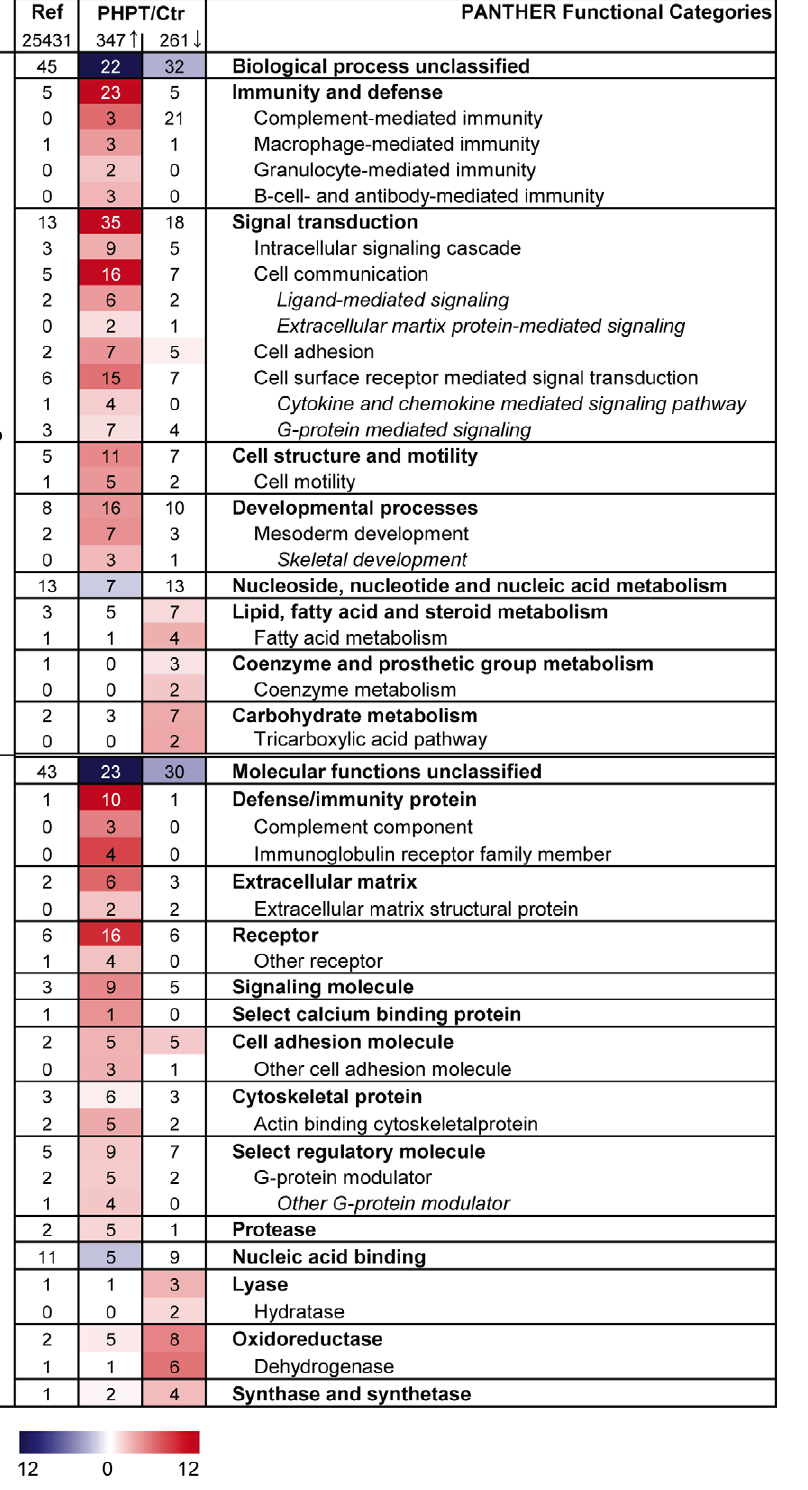
Figure 2. Functional categorization of differentially expressed genes (Biological Process and Molecular Function). Gene expression in subcutaneous adipose tissue in patients with primary hyperparathyroidism was compared to a control group. Over-represented Biological Processes categories and Molecular Function categories among the differentially expressed genes (q-value , 0.05) were found using PANTHER. Bonferroni correction for multiple testing was done and a p-value , 0.01 was used as inclusion criterion for categories. The colour intensity displays the statistical significance ( 2 log p-value) of over- and under-represented PANTHER functional categories. Numbers in the table presents the percentage of genes mapping to a given category, e.g. 23% of the 347 up-regulated genes belonged to the Biological Process category Immunity and defense. The overall distribution of a term among all human NCBI genes (25,431) are stated in the first column, e.g. 5% of the genes are expected to map to the Biological